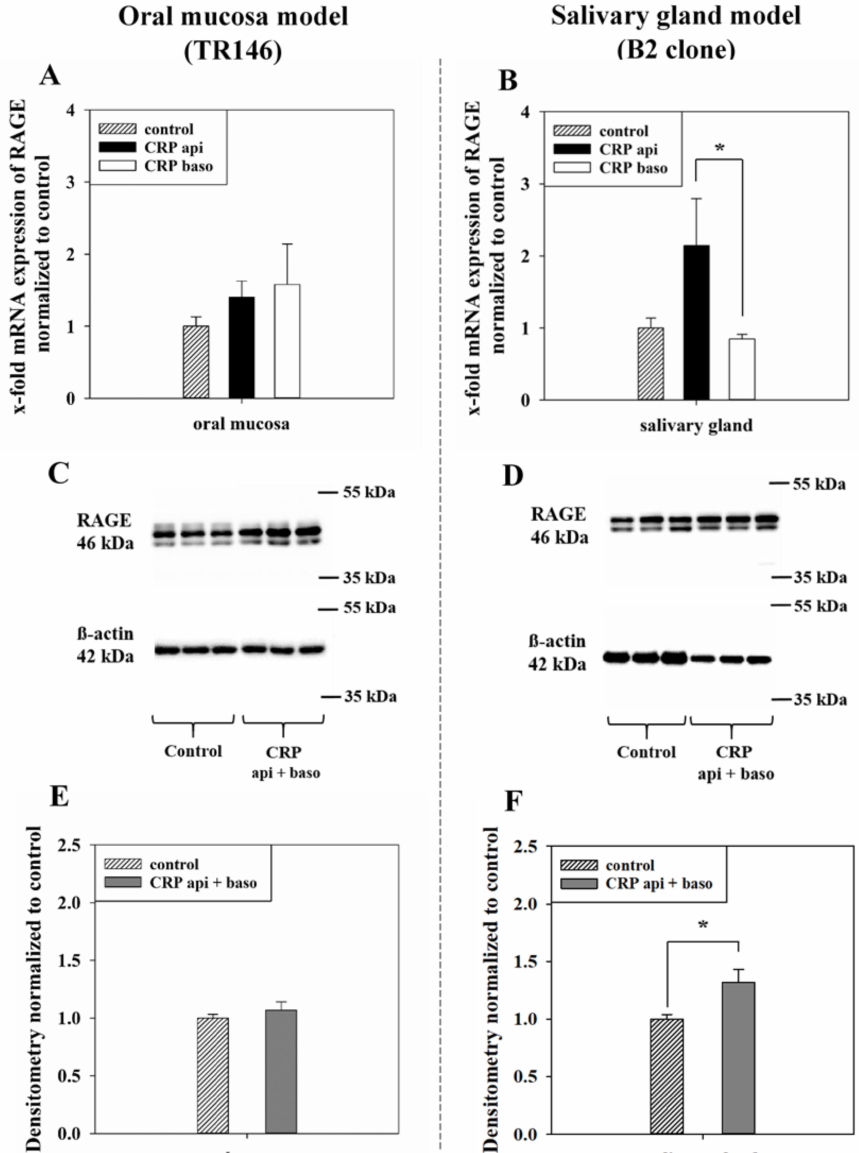
Figure 3. Messenger RNA expression of RAGE of the oral mucosa model (TR146, A ) and salivary gland model (B2 clone, B ) after applying CRP on the apical (api) or basolateral (baso) side for 24 h, Ct values were referred to the endogenous control (18sRNA for oral mucosa or PPIA for salivary gland) and normalized to untreated control samples. Results shown as mean ± SEM of two–three independent experiments (N = 4–7). Statistical analysis was performed as one-way ANOVA on ranks with α = 0.05, * p < 0.05. Representative western blots of RAGE and ß-actin of the oral mucosa model (TR146, C ) and the salivary gland model (B2 clone, D ) after treatment with 10 µ g/mL CRP for 24 h on the apical and basolateral side, compared to control samples. Densitometric values of western blots from two—three independent experiments (N= 3) for the oral mucosa model (TR146, E ) and salivary gland model (B2 clone, F ) shown as mean ± SEM. Statistical analysis was performed as Student’s t -test, with α = 0.05, p < 0.05